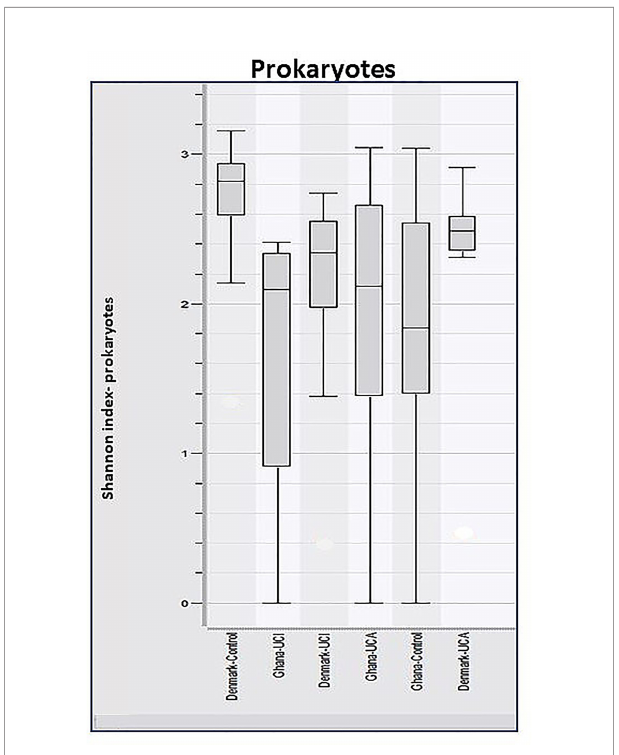
FIGURE 3 | Boxplots of calculated Shannon Diversity Index, divided by study groups show increased prokaryotic diversity in Danish healthy controls and patient groups, in comparison with healthy control and patient group from Ghana, p ≈